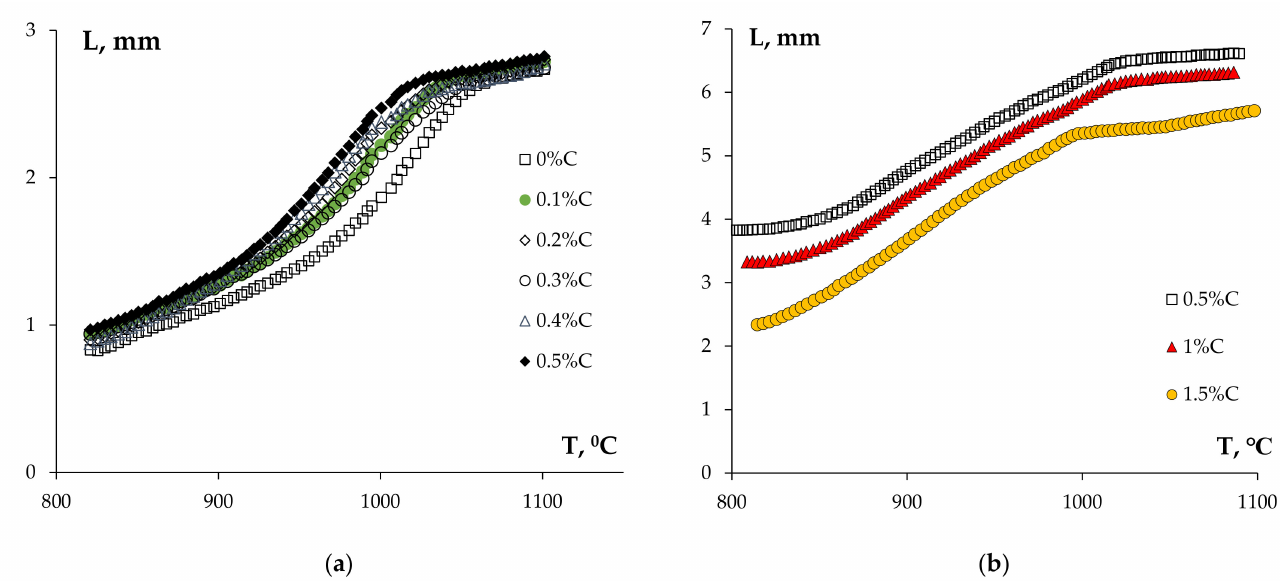
Figure 3. Dependencies of shrinkage on heating temperature L(T) for submicron ( a ) and nanopowders ( b ) α -WC+10 wt.%Co with various graphite